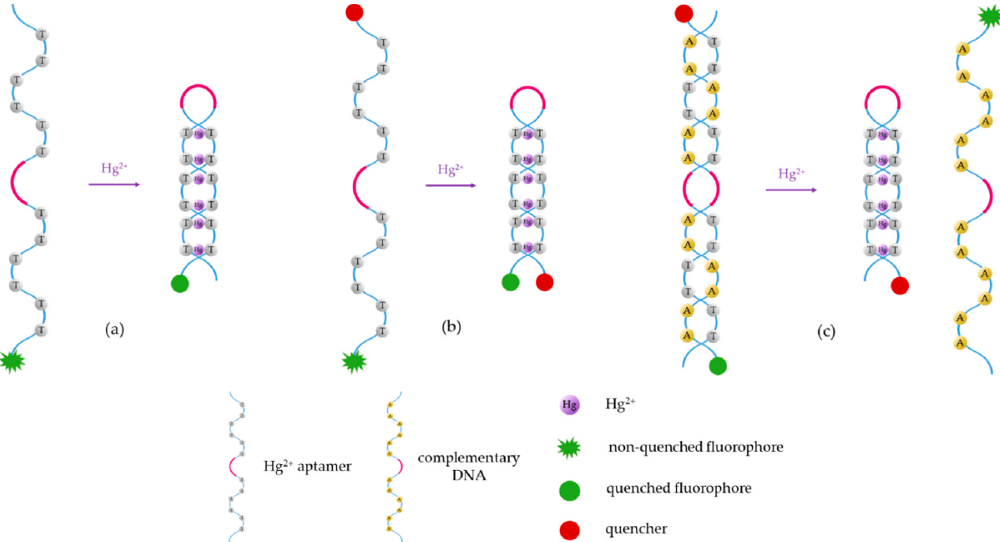
Figure 3. Schematic of the different Hg 2+ sensing procedures utilizing fluorescent aptasensors: ( a ) the fluorophore is labeled to the sensitive aptamer, ( b ) the fluorophore and the quencher are linked to the two terminis of the aptamer, and ( c ) the fluorophore and the quencher are labeled to the aptamer and the complementary DNA, or vice versa. These sensing procedures can be applied to detect other heavy metal ions just by substituting the T-rich sequences by the appropriate ON sequence.